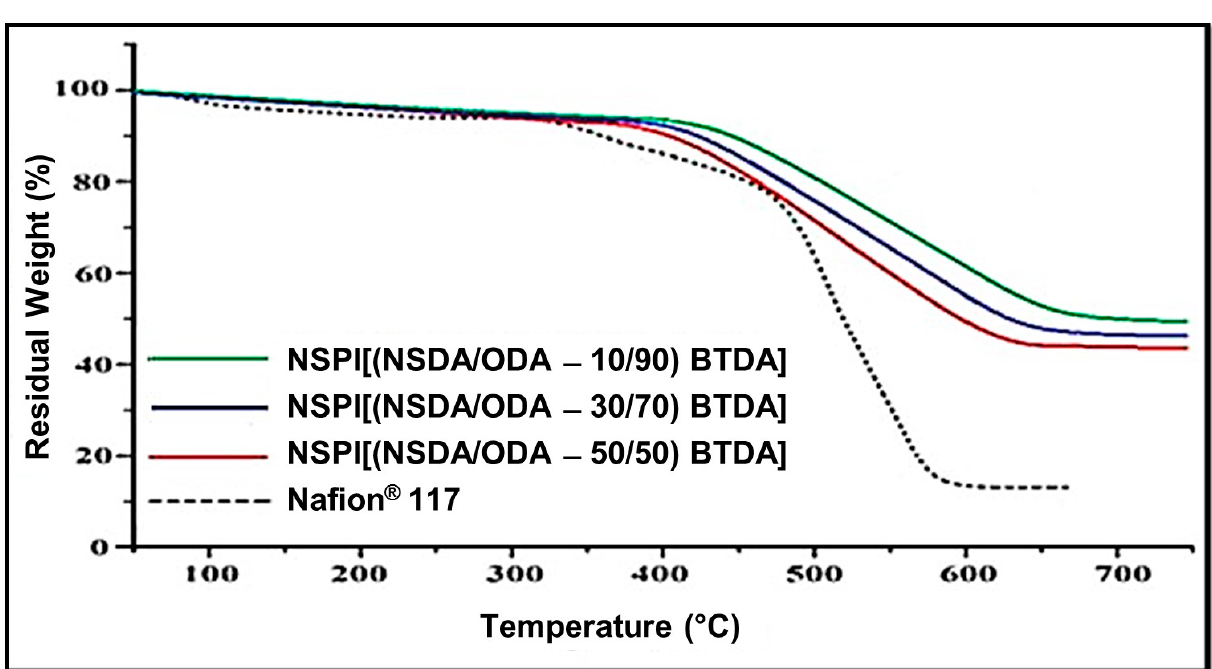
Figure 5. TGA curve of NSPIs and Nafion ® 117 membranes.